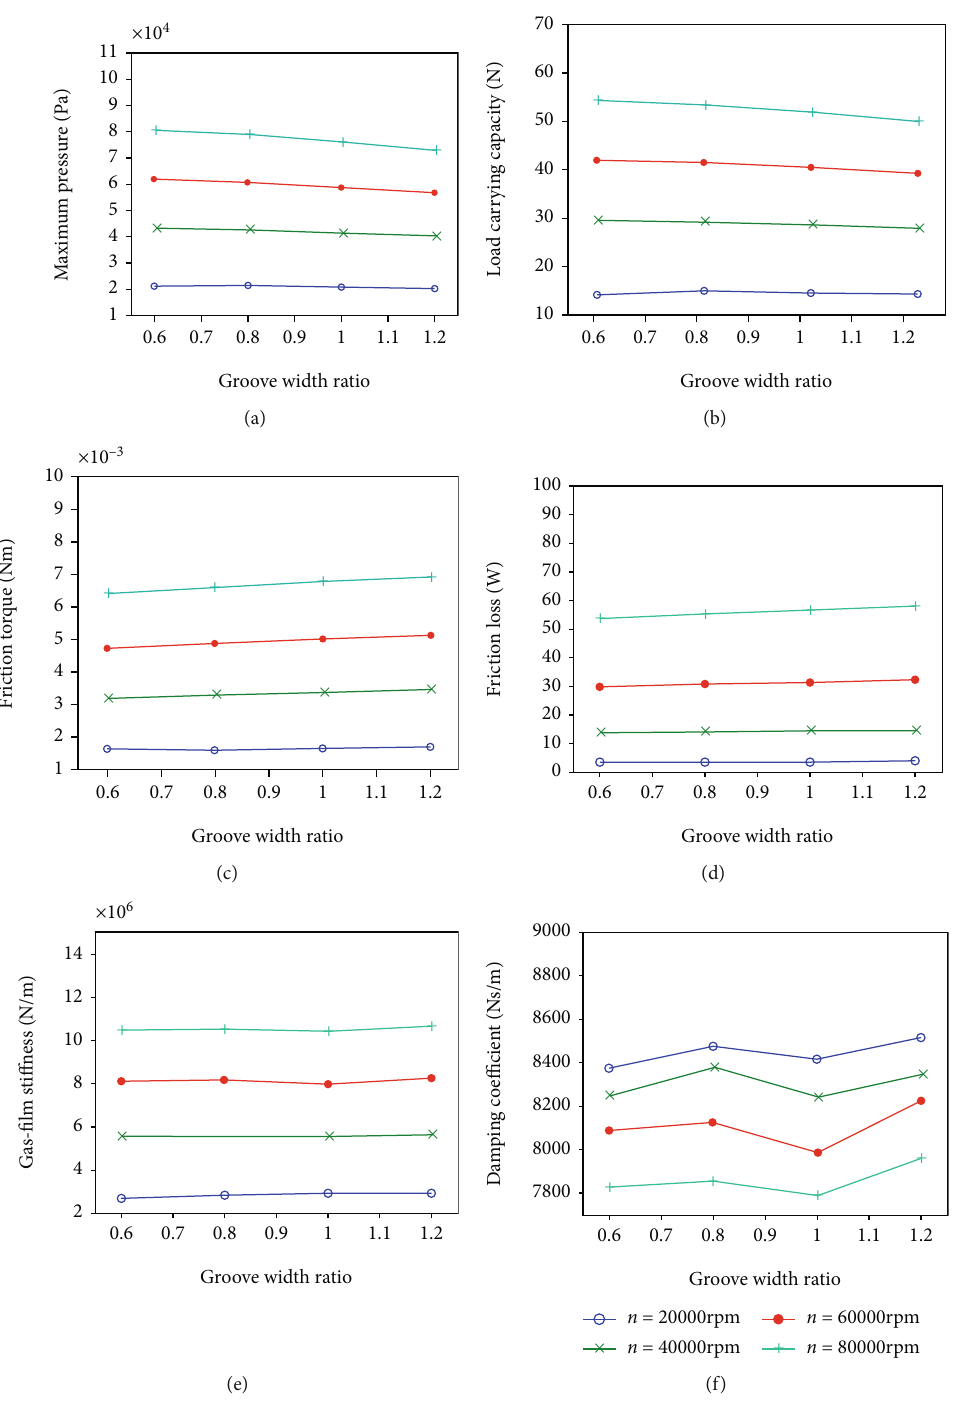
Figure 7: The lubrication performance of spiral-grooved thrust bearing with di ff erent groove width ratios: (a) maximum pressure, (b) load carrying capacity, (c) friction torque, (d) friction loss, (e) gas fi lm sti ff ness, and (f) damping coe ffi